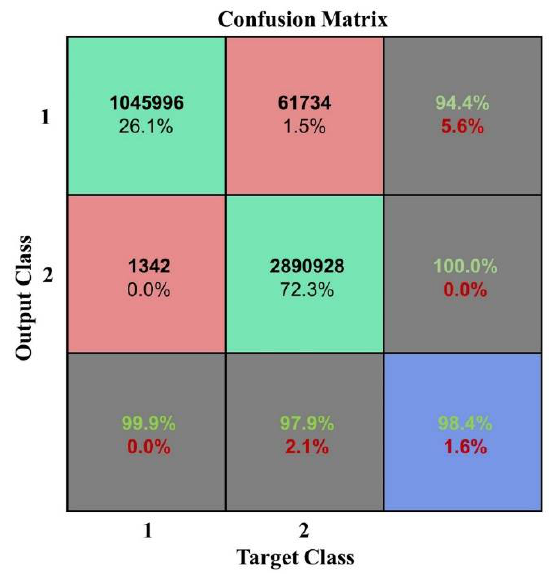
Figure 19. Confusion matrix at a number of iterations of 2.